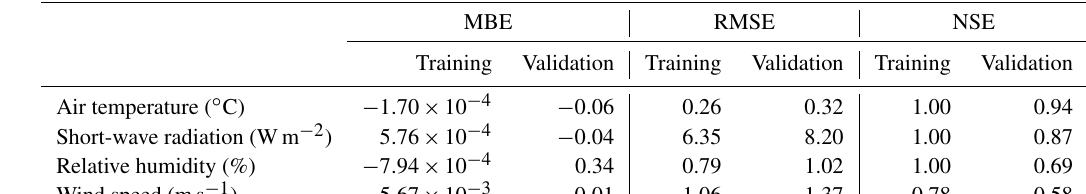
Table 3. GRNN models’ performance evaluation.